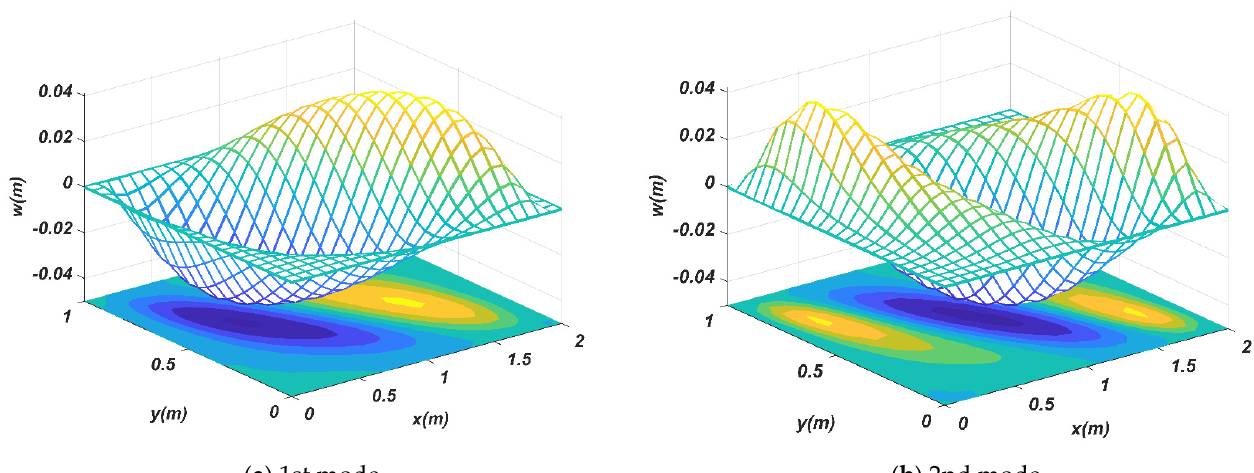
Figure 5. First four buckling mode shapes of a FG-saturated porous plate subjected to a shear load (FCFC, a = 2 m, b = 1 m).